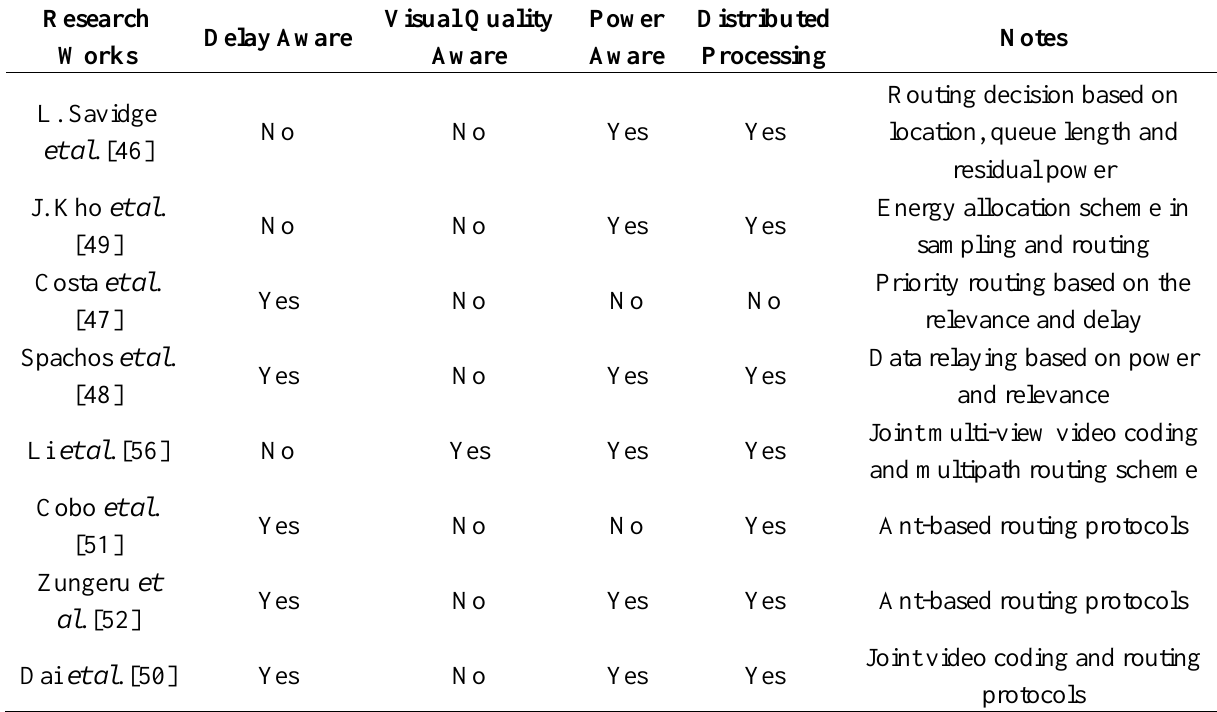
Table 5. Research works on data transmission in